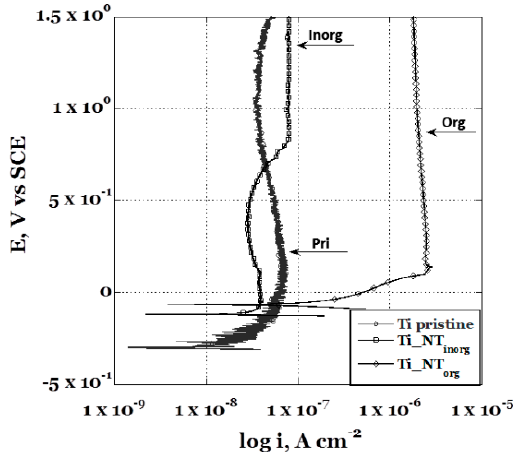
Figure 4. Comparison between the potentiodynamic polarization curves obtained in Hank’s’ solution for the anodized samples in the” inorganic” (Ti_NT inorg sample), the “organic” (Ti_NT org sample) electrolytic solution, and un-treated (Ti pristine sample).